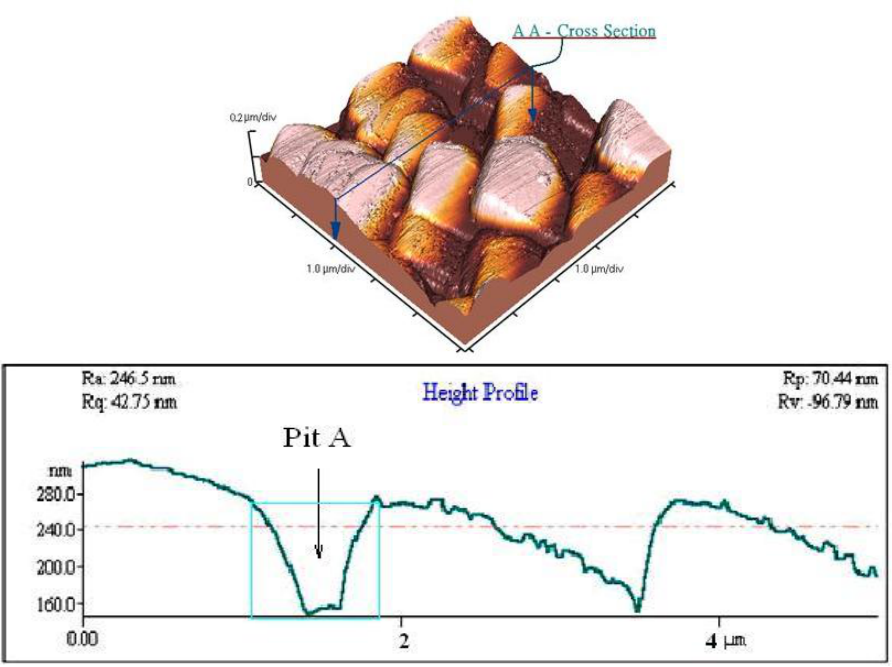
thin film of AFM 2